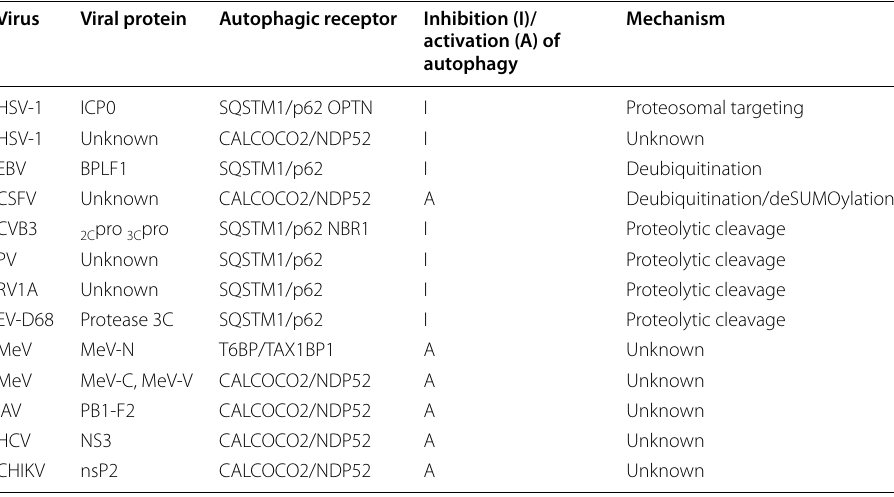
Table 1 Summary of known viral proteins, targeted autophagic receptor and mechanism of inhibition/activation of autophagy Virus Viral protein Autophagic receptor Inhibition (I)/ activation (A) of autophagy